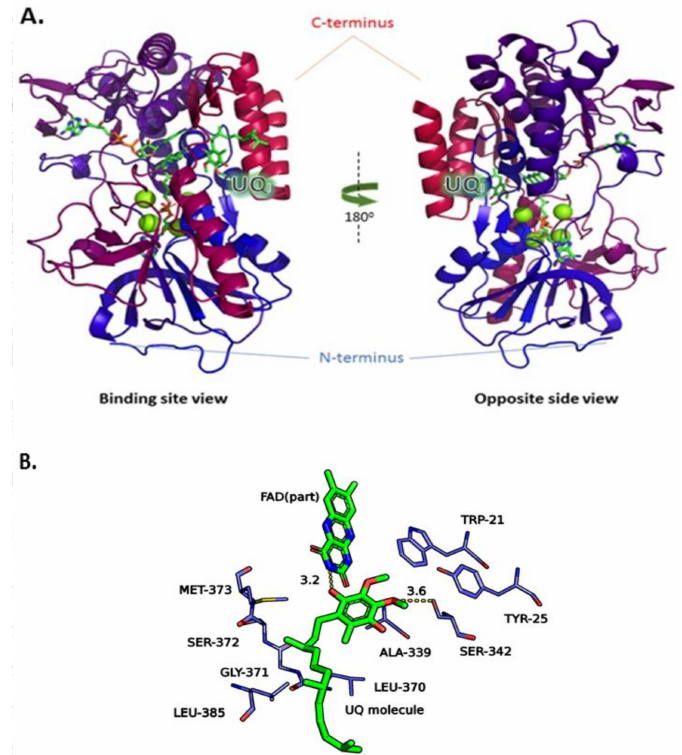
Figure 3. ( A ) Cartoon representation of the homology structural model of Li NDH2 in two orientations. Color code: C-terminus to N-terminus (red to blue); Mg 2+ ions (green spheres); NADH, flavin adenine dinucleotide (FAD) and ubiquinone-binding (UQ) molecules are colored by atom element; ( B ) close up on UQ I (docking data) with flavin group, UQ molecule and residues within 5 Å radius. Interactions with UQ to FAD, 3.3 Å and UQ to Ser342, 3.4 Å are